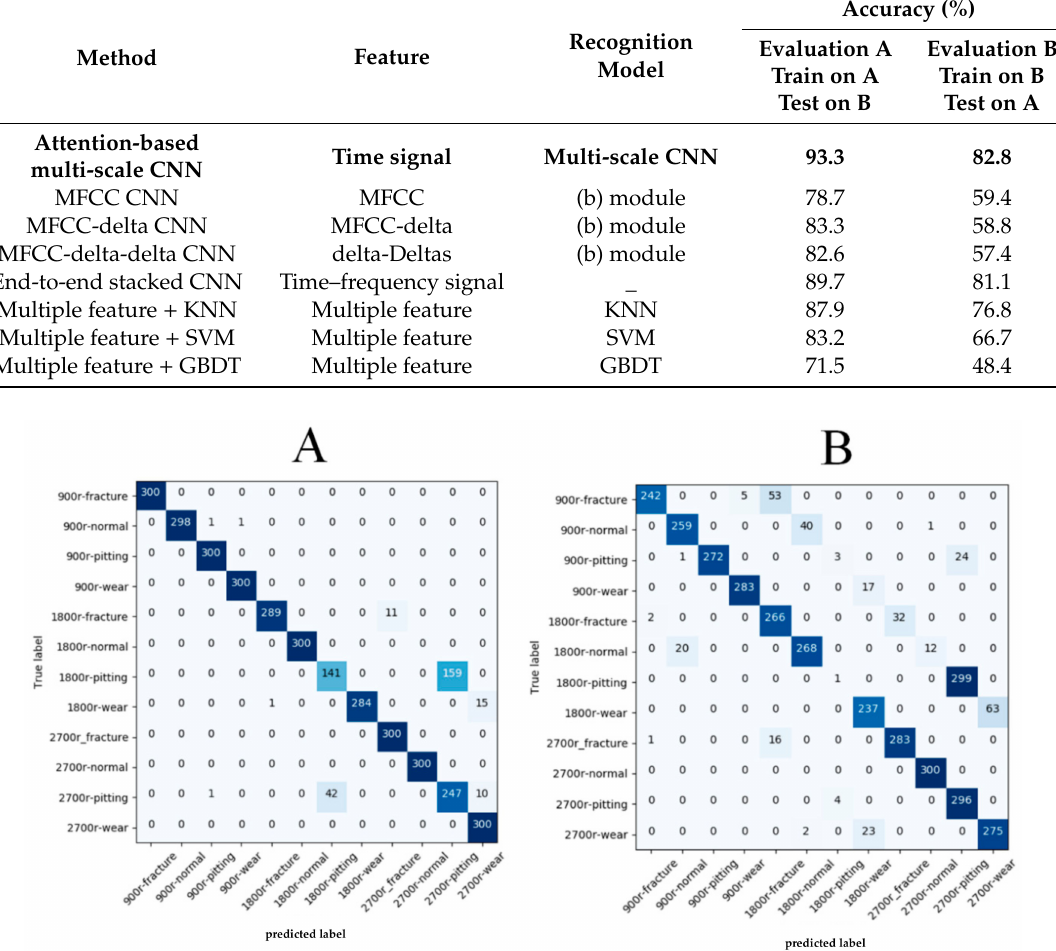
Figure 11. Confusion matrixes for the proposed attention-based multi-scale CNN model. The left matrix shows the statistics for evaluation ( A ), while the right matrix shows the statistics for evaluation ( B